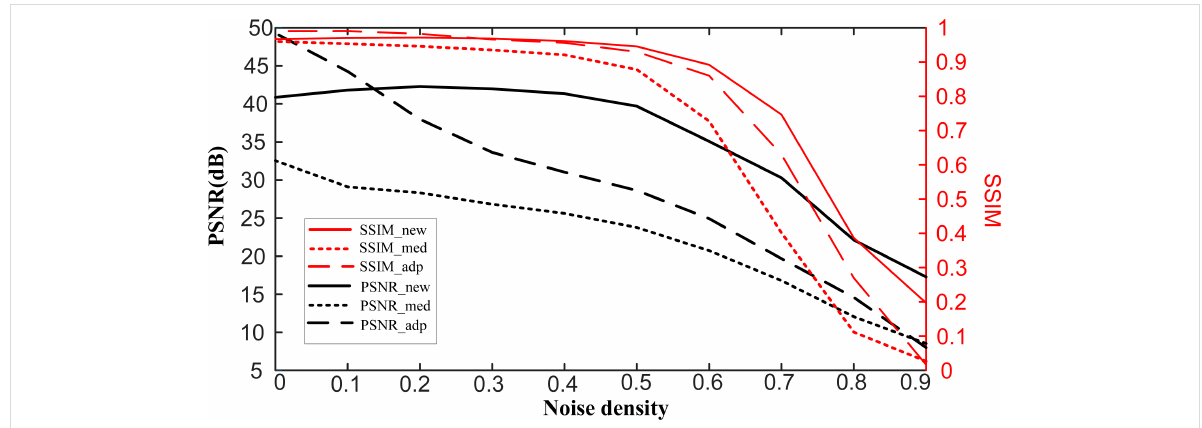
Figure 6: Denoised results comparison of the proposed method, the median filter and the adaptive median filter under different noise density.